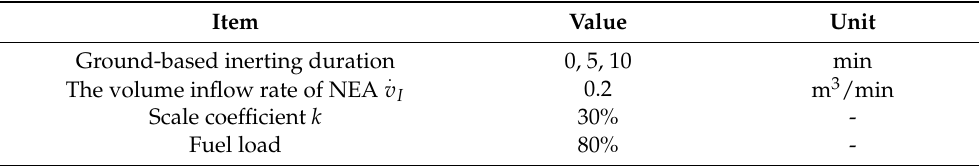
Table 5. The boundary condition of the ullage oxygen concentration analysis regarding the ground- based inerting